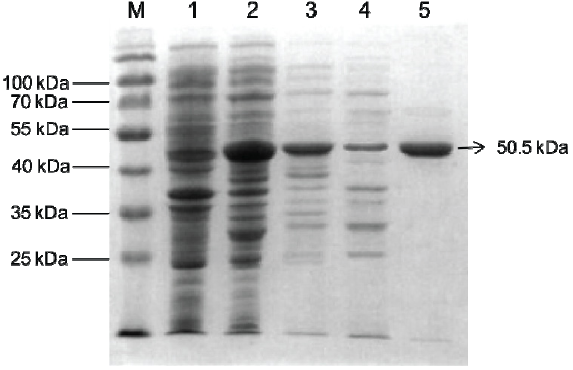
Figure 4. Expression and purification of superoxide dismutase (SOD) recombinant protein. Lane M, molecular weight marker; lane 1, un-induced total protein; lane 2, total protein induced with 0.2 mM isopropyl β - D -1-thiogalactopyranoside (IPTG) for 18 h at 18 °C; lane 3, insoluble proteins; lane 4, soluble proteins; lane 5, purified recombinant protein of GST-Bt-mMnSOD.